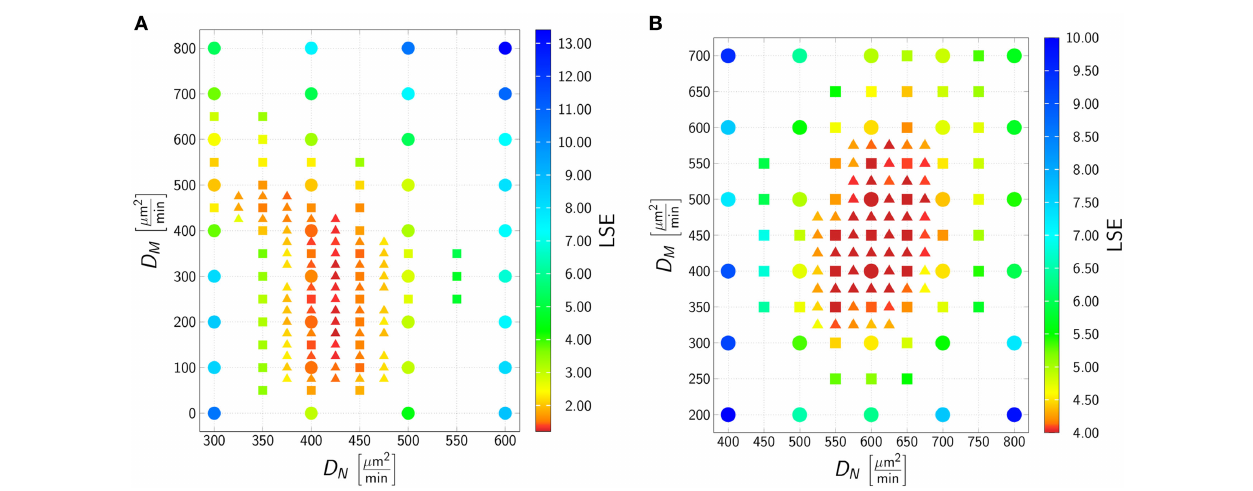
FIGURE 4 | Result of the agent-based model (ABM) parameter estimation for whole-blood infection assays with Candida albicans (A) and Candida glabrata (B) . Adaptive regular grid search was applied to fit the ABM to the experimental data and diffusion coefficients for neutrophils ( D N ) and monocytes ( D M ) were determined. At each grid point 1 μ l blood was simulated, and 30 realizations for each parameter configuration were performed. Three different refinement levels were performed: simulations of the first level are represented as dots, simulations of the second level are represented as squares, and simulations of the third level are represented as triangles. The best fit to the experimental data was found at ( D min N ; D min M ) = ( 425 μ m 2 = min ; 175 μ m 2 = min ) for C. albicans and at ( D min N ; D min M ) = ( 600 μ m 2 = min, 425 μ m 2 = min ) for C. glabrata